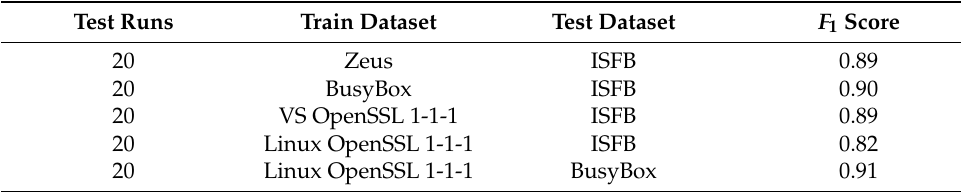
Table 14. Bipartite Matching